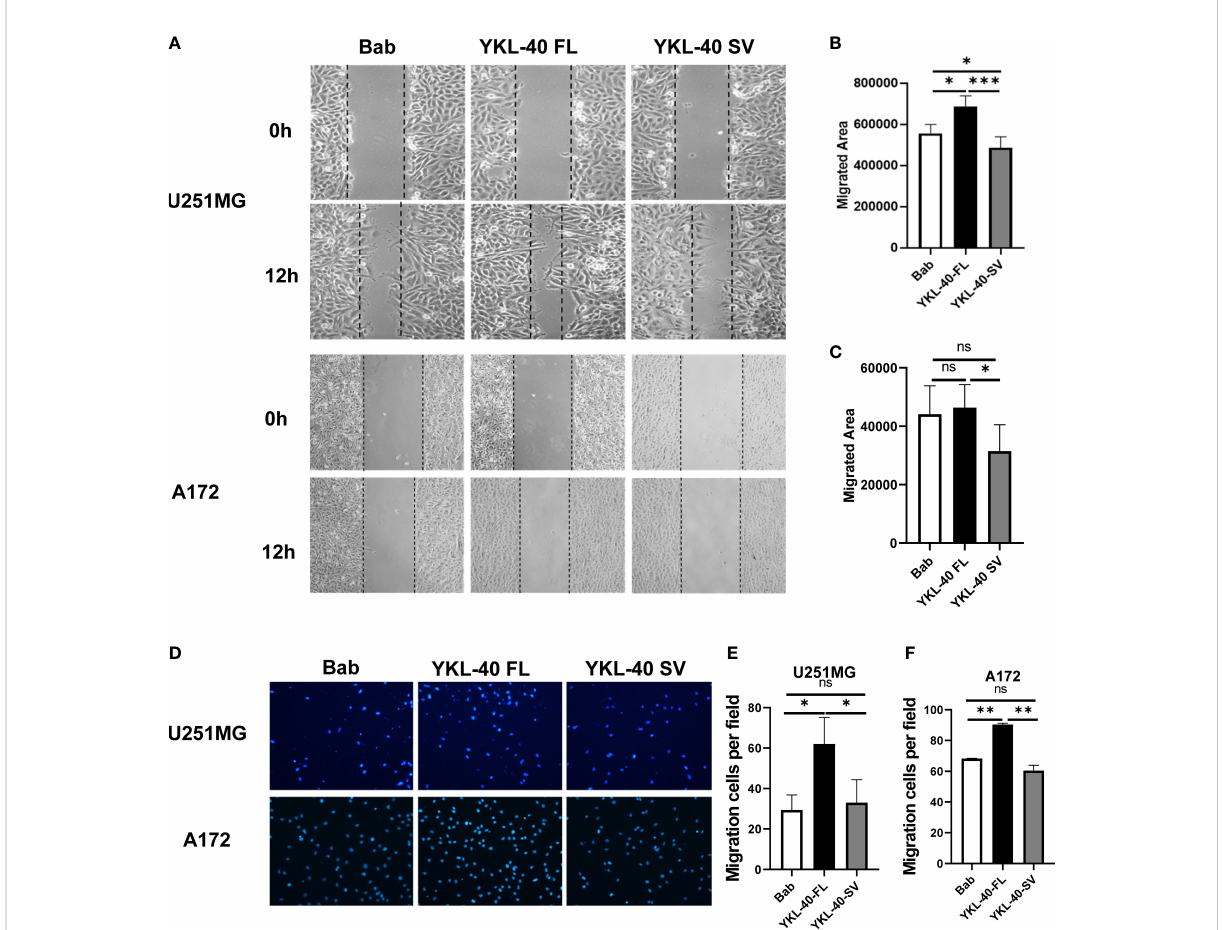
FIGURE 5 The short variant of YKL-40 signi fi cantly inhibits horizontal migration. (A) Monolayers of U251MG or A172 cells were scratched with a 200 m l pipette tip when they reached 95% con fl uence. Representative images of migrating cells were taken under an inverted microscope (magni fi cation 40×). (B, C) The migration of the U251MG and A172 cells was quanti fi ed by wound closure areas 12 h after scratching (wound gap area – area after closure). (Bars, SD. One-way ANOVA. * p < 0.05; ** p < 0.01; *** p < 0.001; ns, no signi fi cant difference. n = 6). (D) U251MG or A172 cells that migrated to the bottom side of the transwell chamber were fi xed and stained with DAPI. Representative images of migrating cells were taken under an inverted microscope (magni fi cation 100×). (E, F) The number of migrated cells was quanti fi ed by Fiji-ImageJ software. (Bars, SD. One-way ANOVA. * p < 0.05; ** p < 0.01; *** p < 0.001; ns, no signi fi cant difference. n =